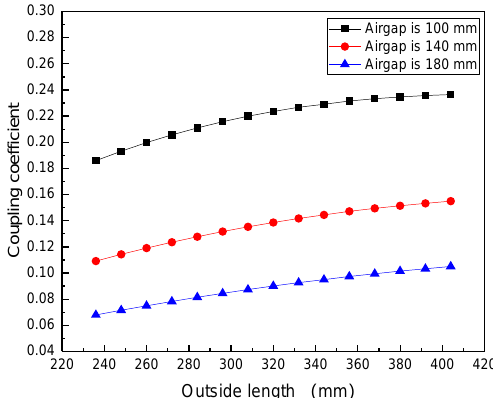
Figure 14. Coupling coefficient versus the outer side length.